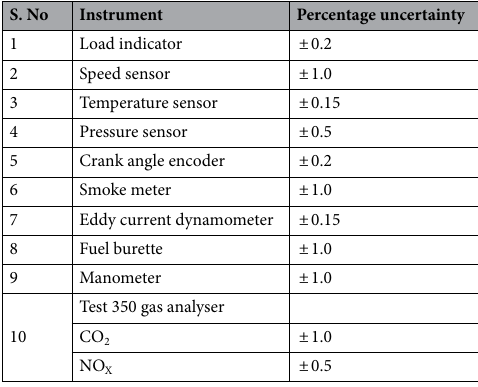
Table 6. Uncertainty analysis of test engine.